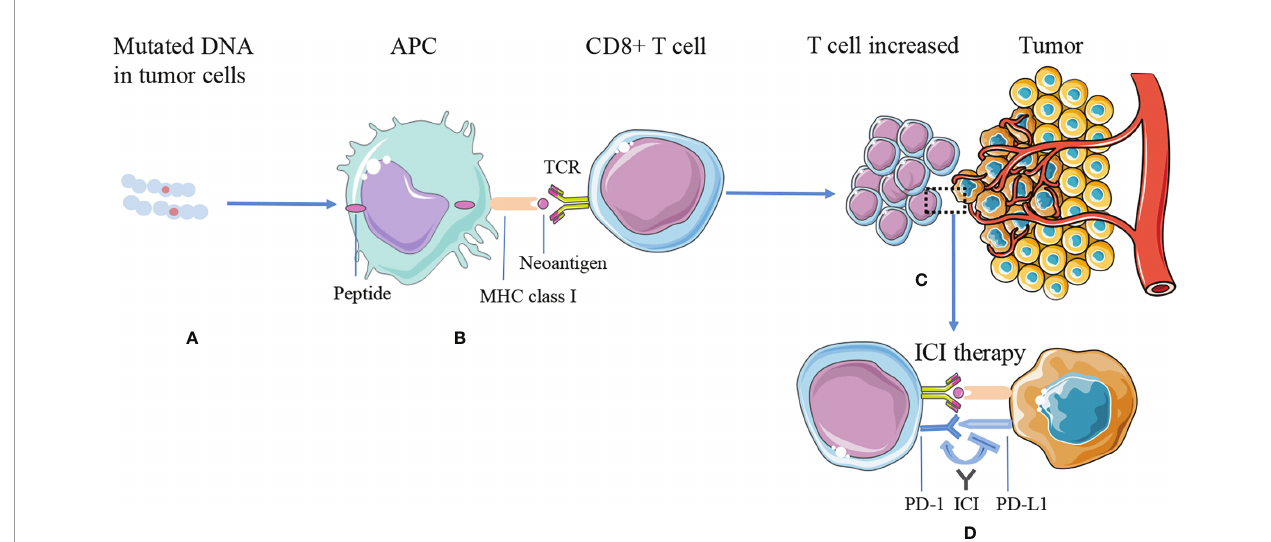
FIGURE 1 | The mechanism of tumor antigen processing, presentation on MHC class I, and improving ef fi cacy of ICI therapy. (A) DNA mutations occurred and synthesized proteins in the tumor cells. (B) The proteins are processed into smaller peptides, displayed by major histocompatibility complex (MHC) class I molecules via APC cells, and recognized by CD8+ T effector cells as neoantigens. (C) Tumors expressing higher numbers of neoantigens are more likely to induce a signi fi cantly greater number of T cells, while tumor cells inhibit T-cell function through immune checkpoints, such as PD-L1. (D) ICI therapy blocks immune checkpoint suppression, reactivates T-cell function, and kills tumor cells. APC, antigen-presenting cell; ICI, immune checkpoint inhibitor; MHC, major histocompatibility complex; PD-L1, programmed cell death ligand 1; PD-1, programmed death receptor 1; TCR, T-cell